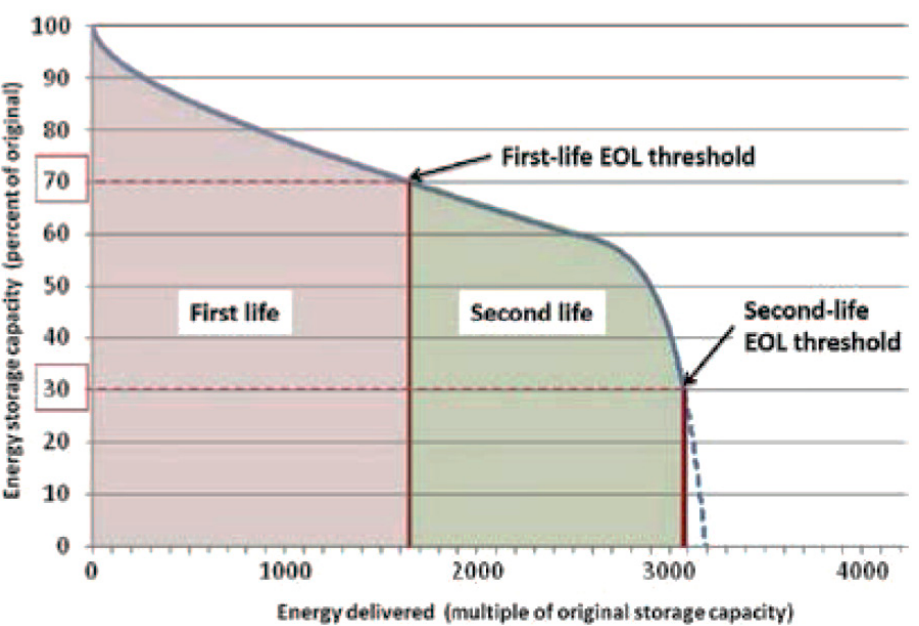
Figure 5. Estimation of Second Life of Batteries [22].